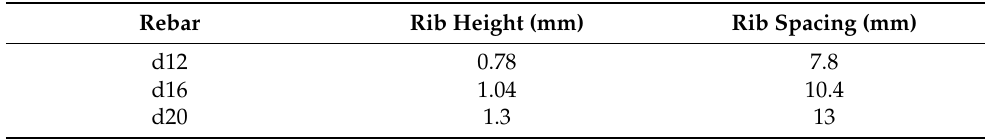
Table 3. Details of rebar.